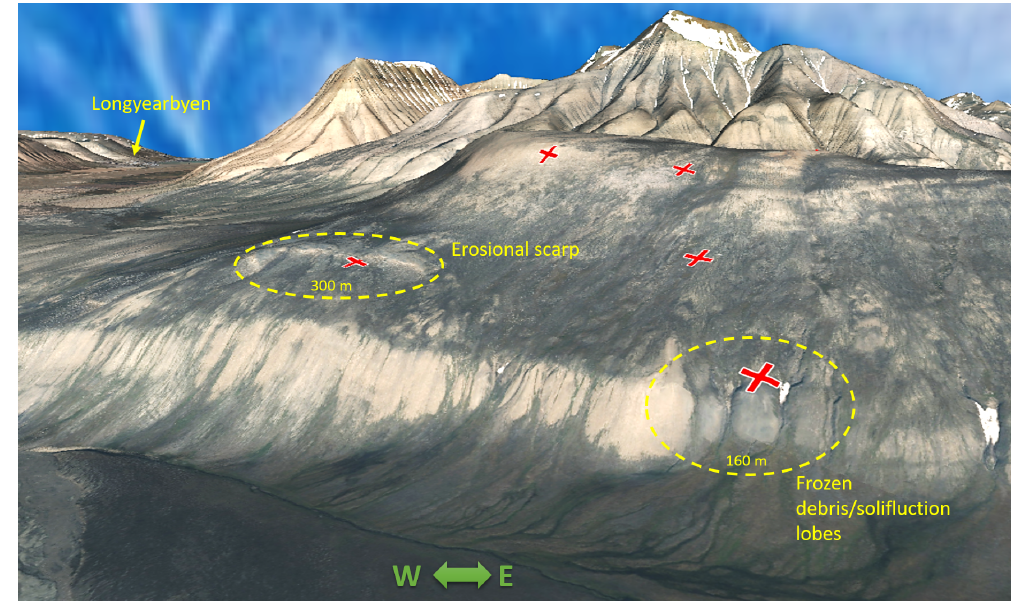
Figure A1. Three-dimensional perspective view of the southern flank of Janssonhaugen highlighting two of the three areas associated with anomalous seismicity. The three-dimensional model was constructed by draping an orthophoto on top of a 1 . 5 × vertically exaggerated digital elevation model (DEM). Red crosses mark locations of SPITS seismometer stations. Orthophoto and DEM © Norwegian Polar Institute (https://npolar.no, 17 January 2022).